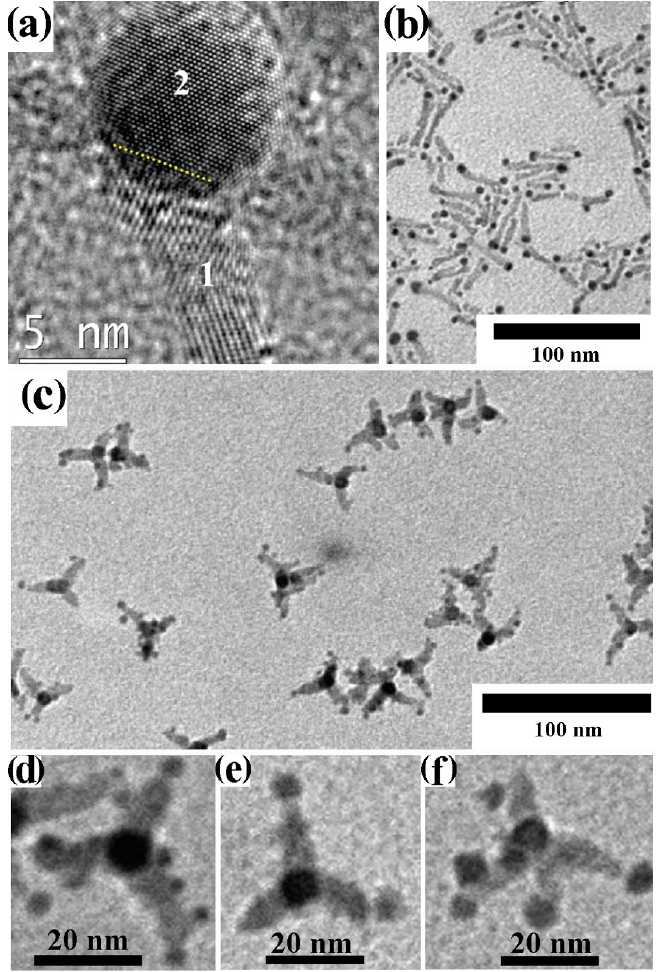
Figure 12. Collection of representative anisotropic CNHSs obtained by a surfactant-controlled selective heterogeneous nucleation-growth mechanism (cf. Scheme 4). The panel show: ( a , b ) HRTEM image (where “1” denotes the TiO 2 , while “2” denotes Co) and TEM image of CNHSs composed of Co-tipped anatase TiO 2 nanorods (reproduced with permission from Ref. [315], Copyright 2007, American Chemical Society); ( c – f ) variable-magnification TEM images of heteromer CNHSs made of Co-decorated γ -Fe 2 O 3 tetrapod-shaped nanocrystals (reproduced with permission from Ref. [318], Copyright 2009, American Chemical Society).